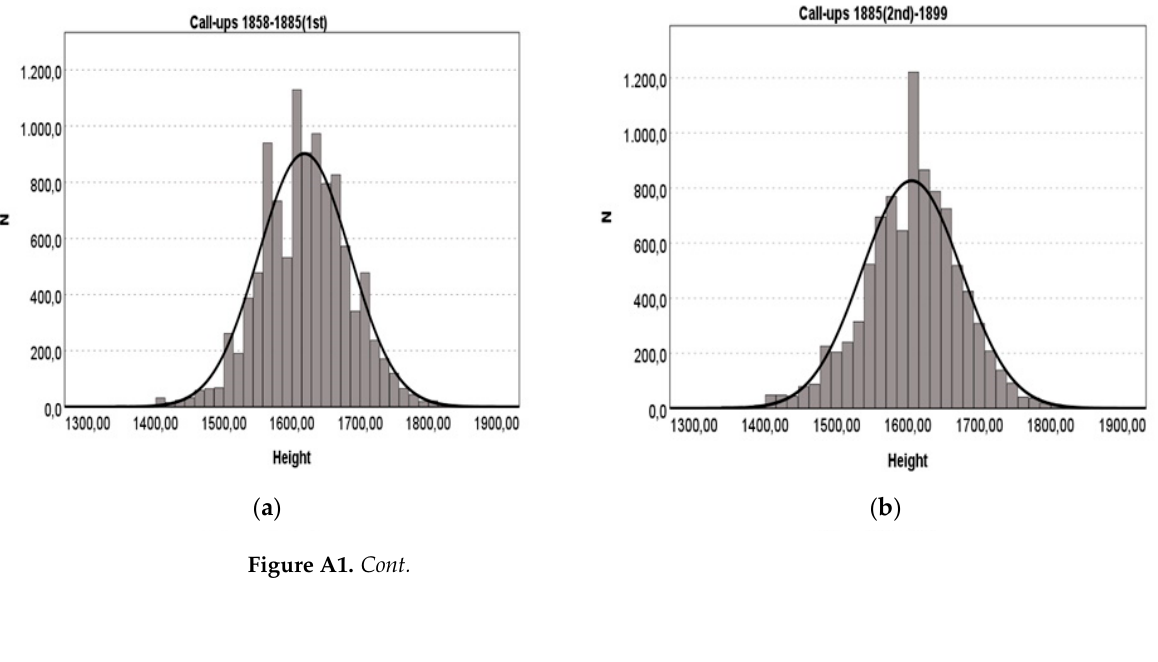
( d ) Figure A1. Histograms with the distributions of heights. Call-ups 1858–1936 (Source: built with data from the corresponding Expedientes ). Data expressed in thousands with “.” and decimals with “,” in the axes. References 1.